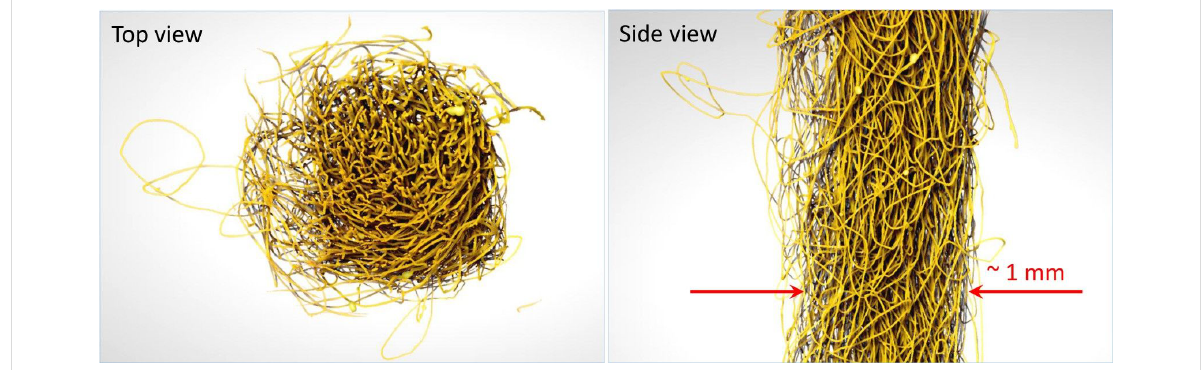
Figure 1: X-ray tomographic images showing 3D rendered volumes of white Bombyx mori silk fibers at 3.15 μ m pixel resolution. The bundle of silk fibers is composed of degummed single-strand silk fibers.